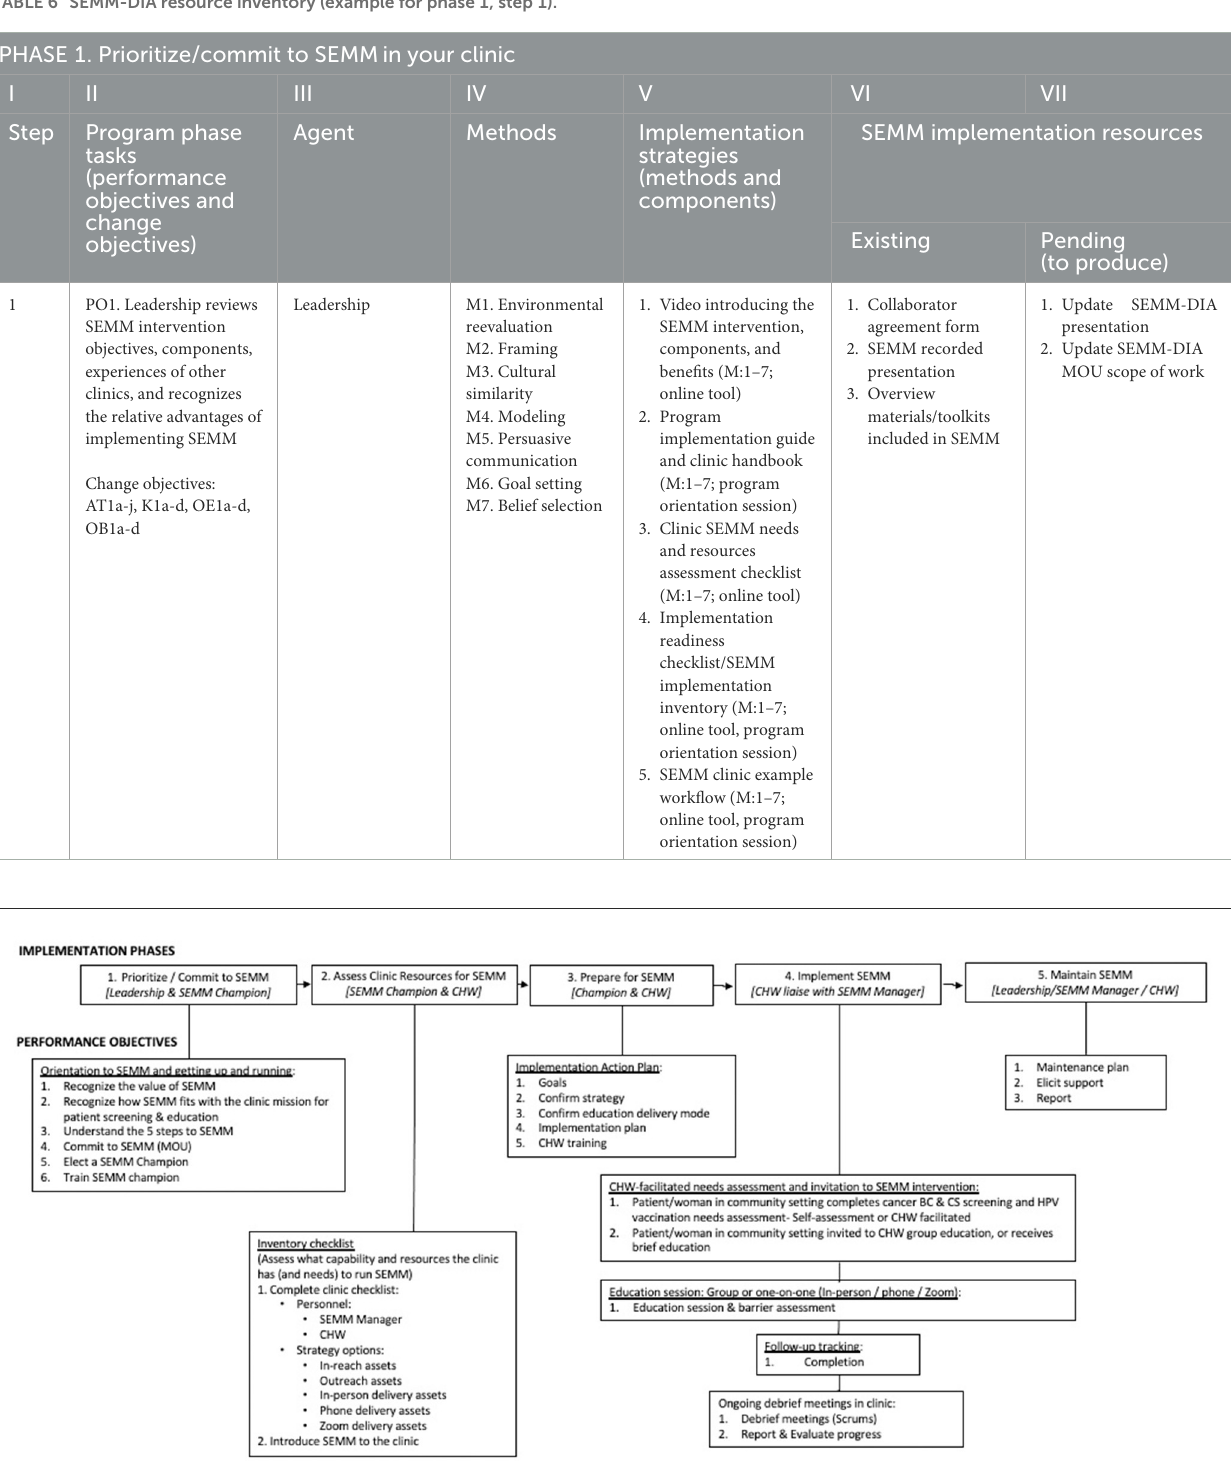
FIGURE2 SEMM-DIA design